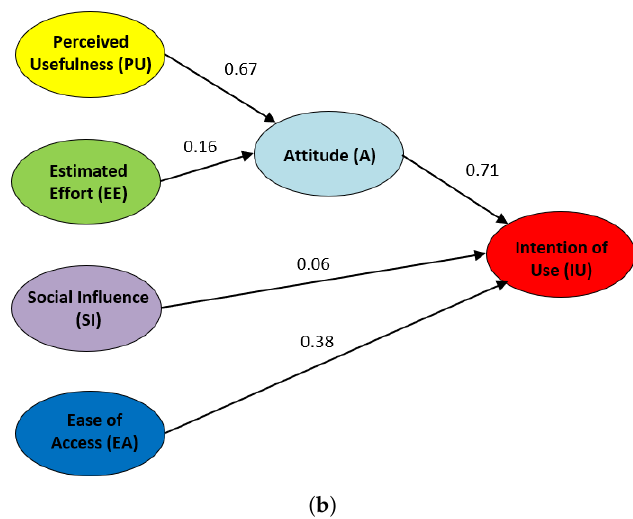
Figure 10. SEMs for the LoT@UNED and CVL Technologies with the UTAUT model. ( a )